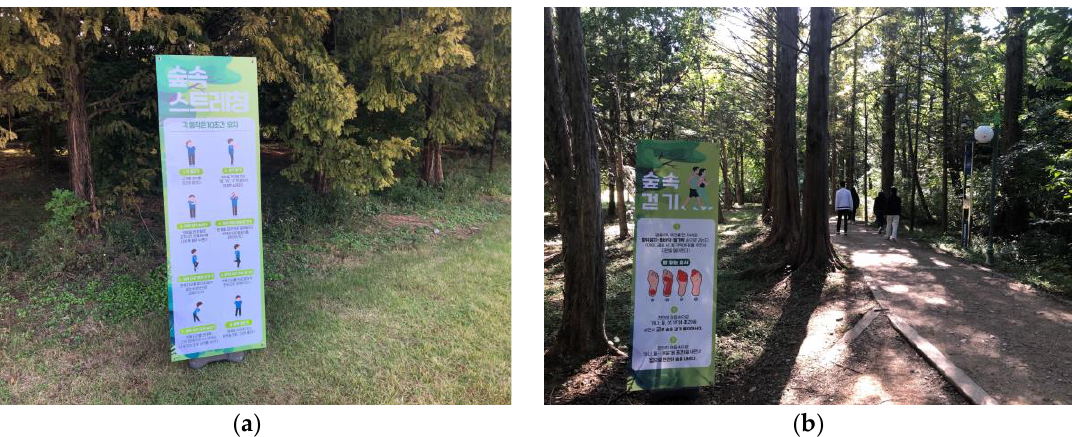
Figure 2. Example of a self-guided forest healing program guideboard. ( a ) stretching; ( b ) walking.